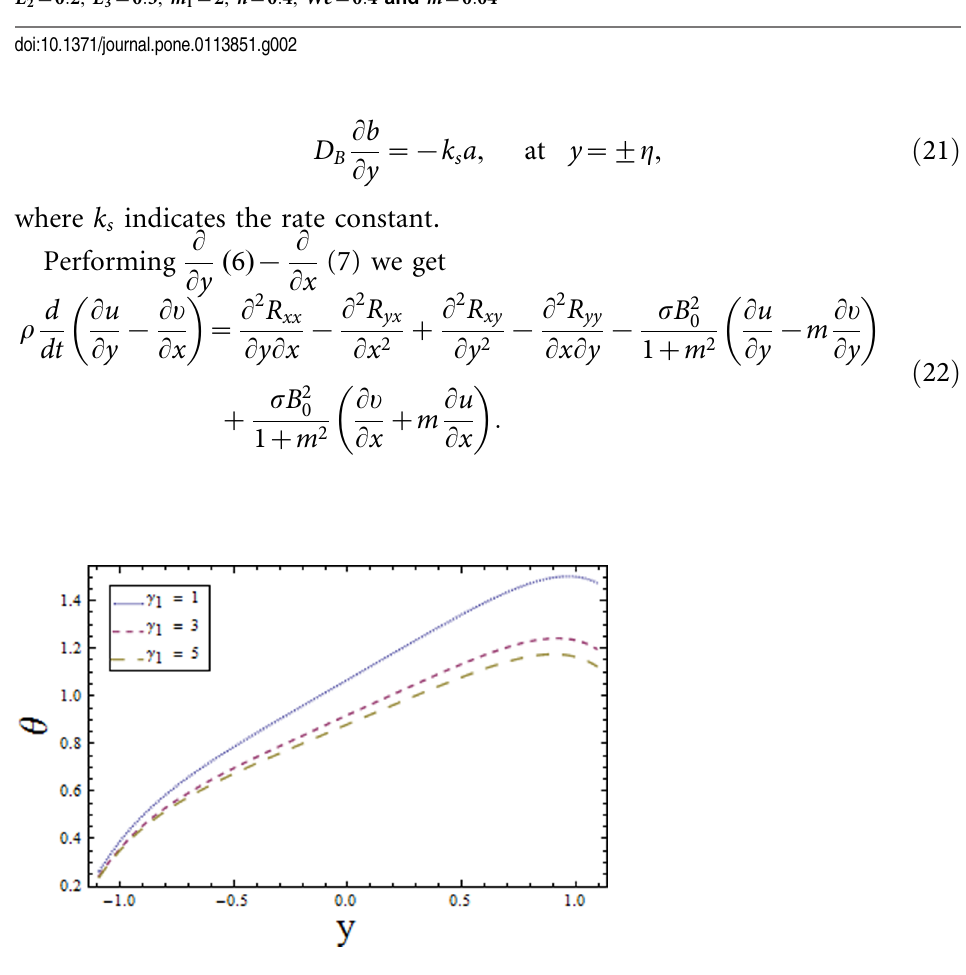
Figure 2. Plot of temperature h for Brinkman number Br with E ~ 0 : 1 , t ~ 0 : 01 , x ~ 0 : 2 , ª 1 ~ 4 , ª 2 ~ 6 , E 1 ~ 0 : 4 , E